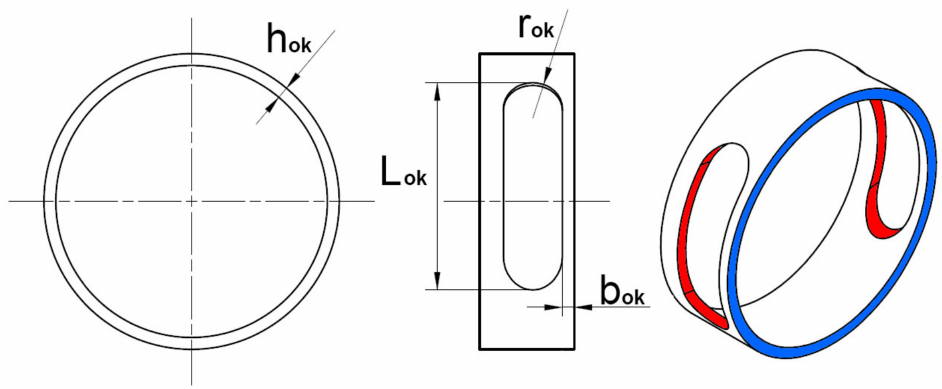
Figure 17. Simplified geometry of a gap in the commutation window: red—inlet; blue—outlet.